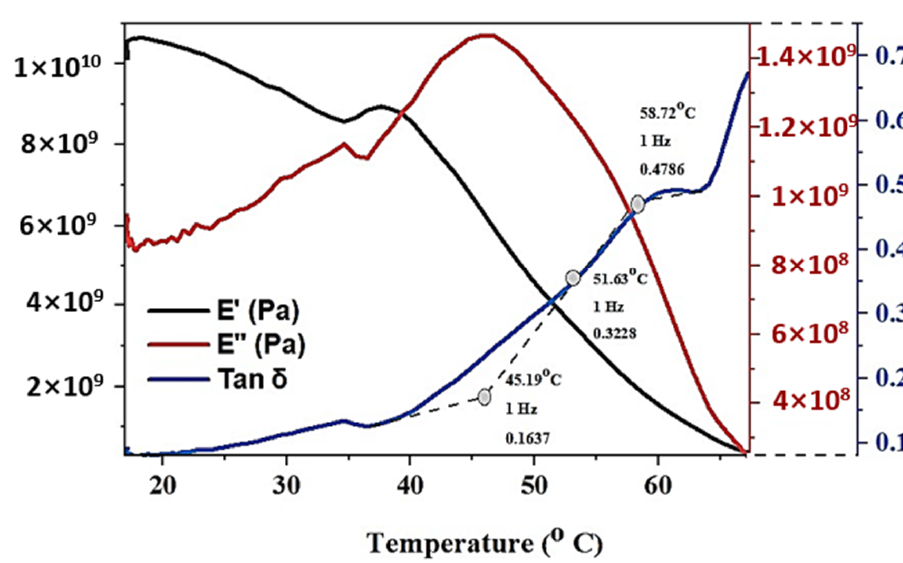
Figure 13. DMA analysis for tBA-co-DEGDA resin built under optimal conditions.